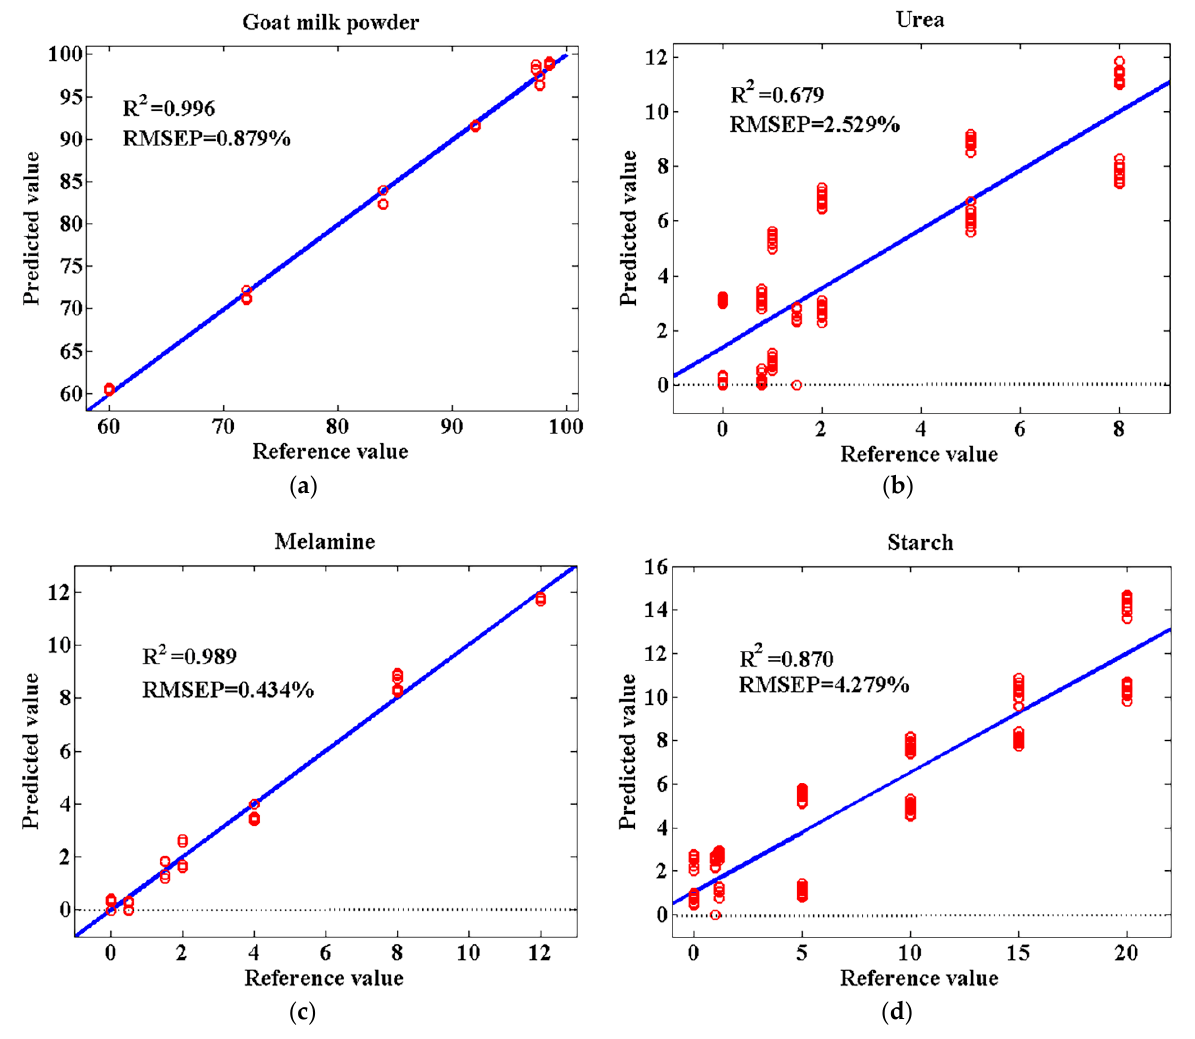
Figure 8. Predicted vs. reference plots for prediction set of the MCR-ALS model for goat milk powder determination ( a ), urea determination ( b ), melamine determination ( c ), and starch determination ( d ) based on the spectra without pretreatment.